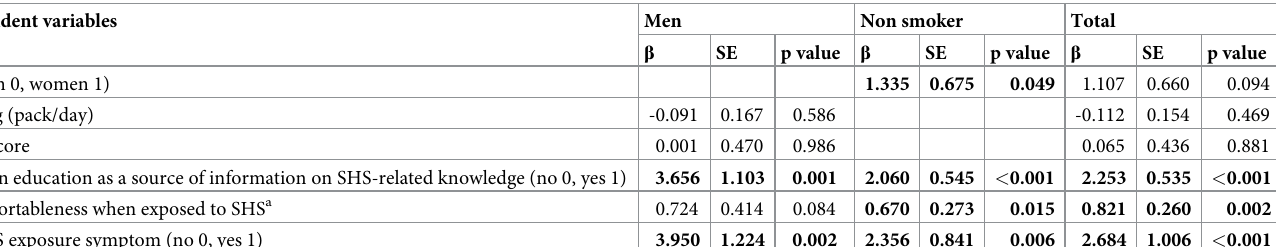
Table 4. Multiple regression analysis for the prediction of SHS